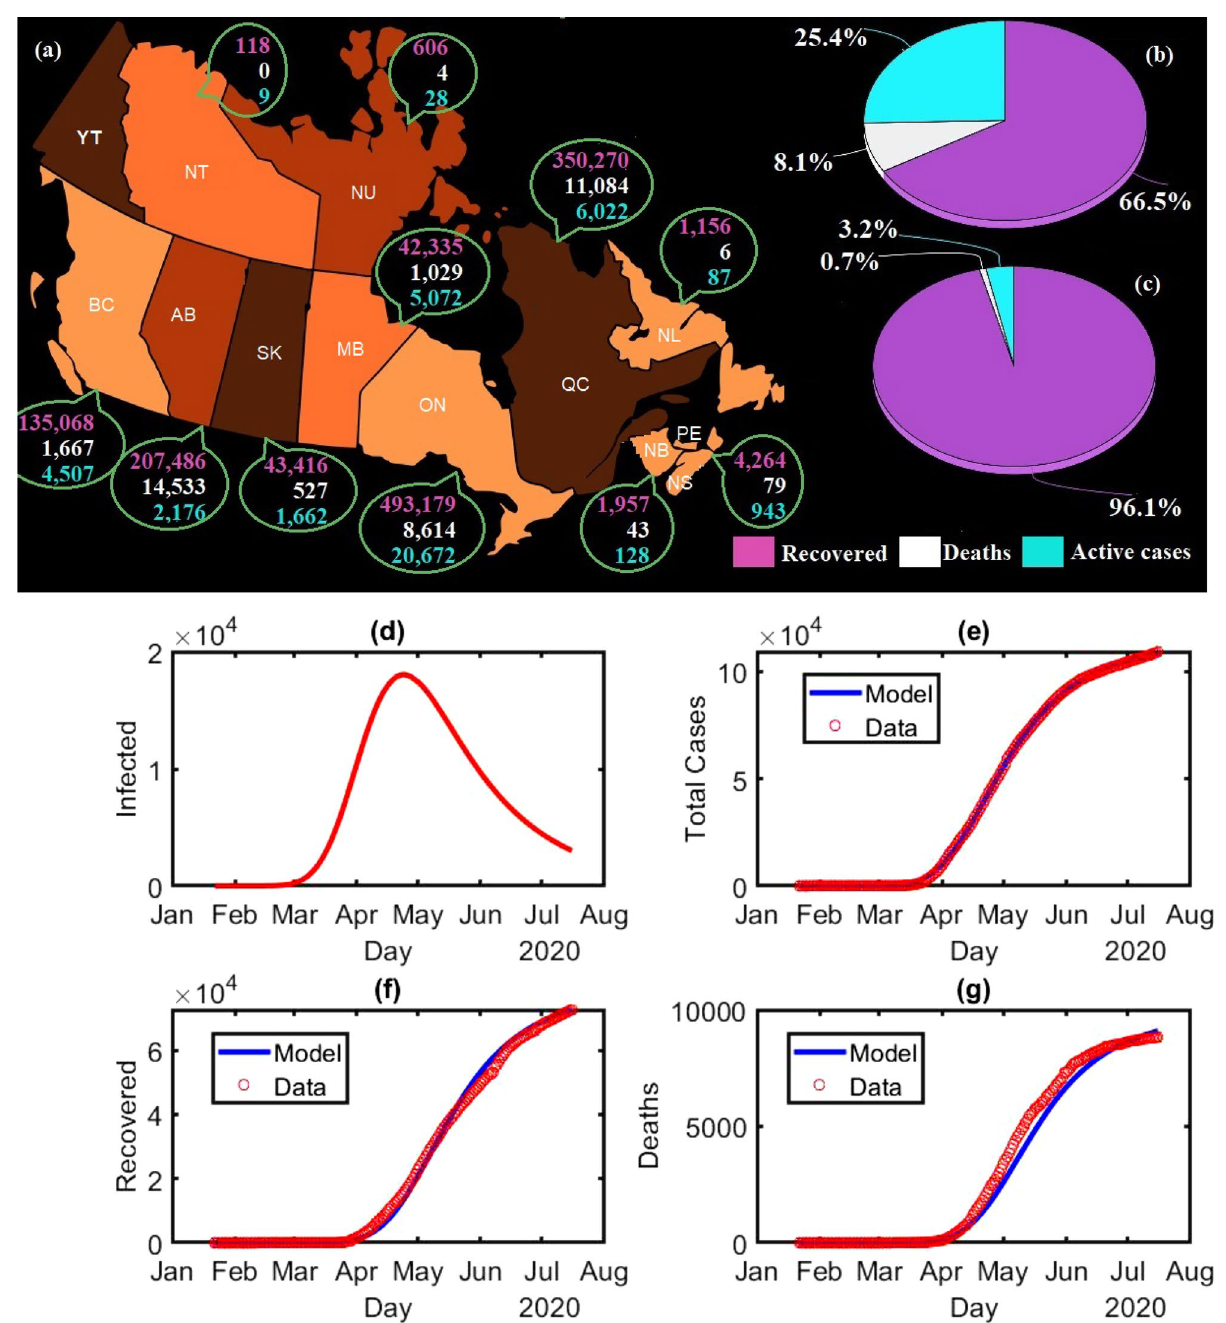
Figure 1. COVID-19 pandemic in Canada: ( a ) As of May 23, 2021 Canadian out break at-a-glance; the purple, white and cyan digits are represented the number of recovered individuals, death toll and active cases, respectively. ( b ) Percentage of recovered (purple), deaths (white) and active cases (cyan) in Canada during the first wave, January 22, 2020 to July 16, 2020. ( c ) Percentage of recovered (purple), deaths (white) and active cases (cyan) in Canada as of May 23, 2021. The image has been generated using Microsoft Paint—Windows 10. Model calculation for Canada during the first wave, January 22, 2020 to July 16, 2020: ( d ) Estimation of the number of infected individuals. ( e ) Estimation of the total number of coronavirus cases compared to the available data 30 . ( f ) Estimation of the total number of recovered compared to the available data 30 . ( g ) Estimation of the total number of deaths compared to the available data 30